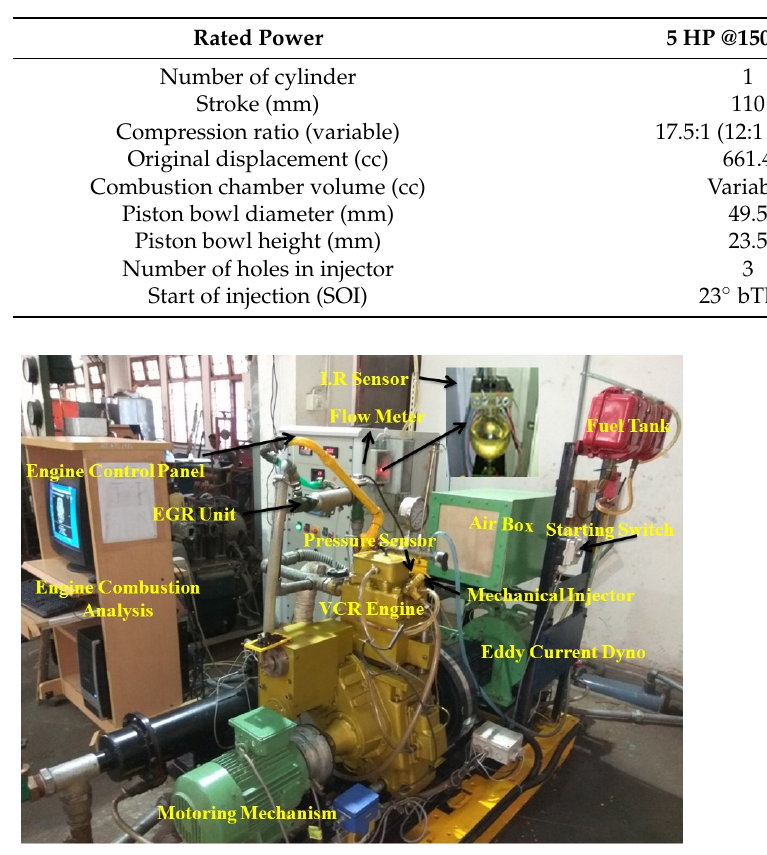
Table 2. Technical specification of the engine.